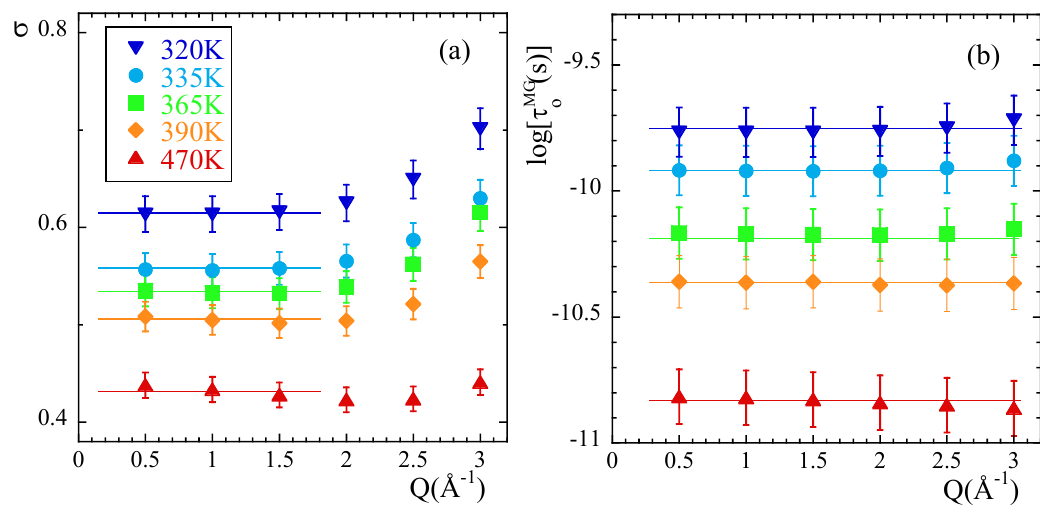
Figure 9. Momentum transfer dependence of the RRDM parameters σ ( a ) and τ MG o ( b ) obtained from the fit of F rel s ( Q , t ) at the temperatures indicated in ( a ). Lines show the values considered as representative for these